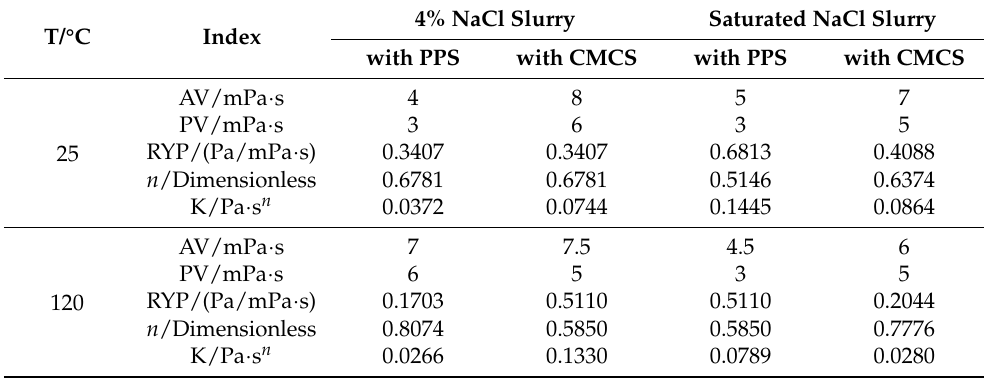
Table 4. Rheological property results of the drilling fluids with the addition of PPS or CMCS.